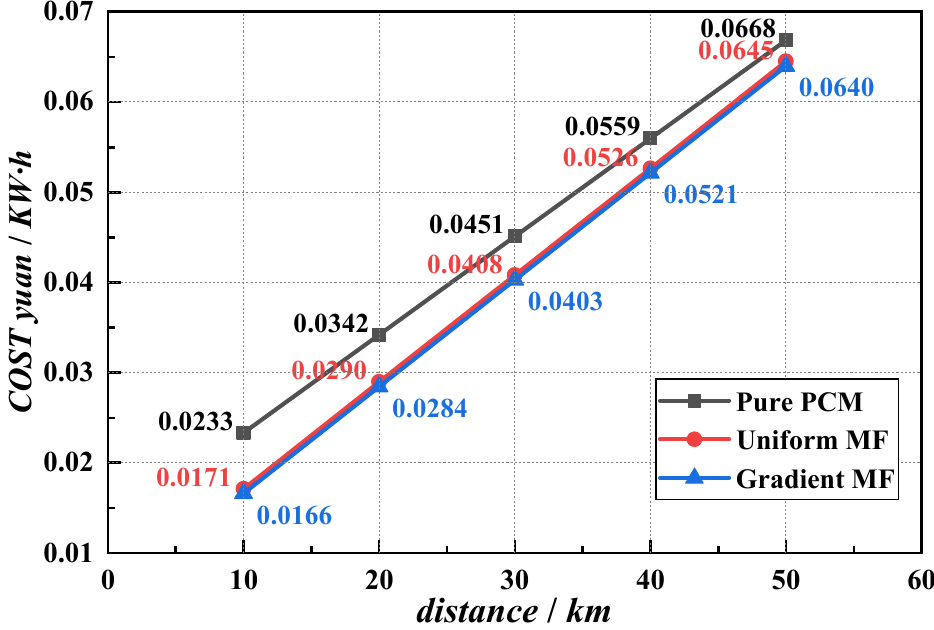
Figure 6. Cost varies with distance under three structures.